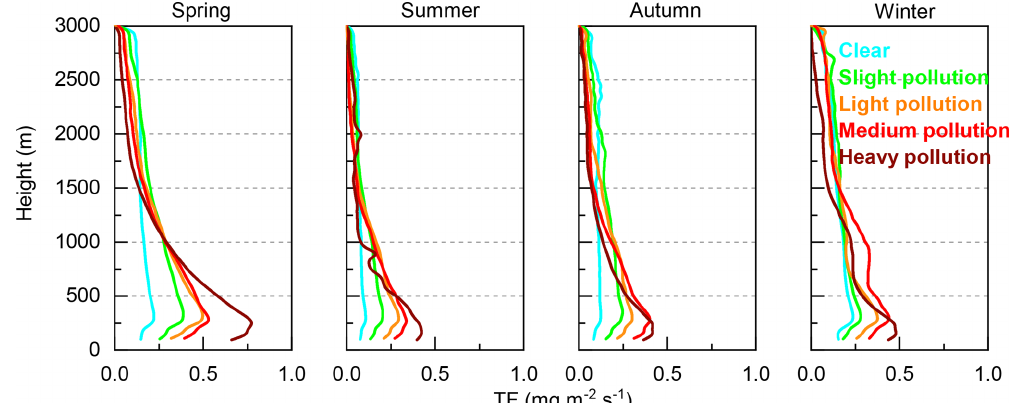
Figure 7. Vertical profiles of TF of PM 2 . 5 under different degrees of pollution in different seasons in Beijing. Clear days: PM 2 . 5 ≤ 35µgm − 3 . Slight pollution: 35 < PM 2 . 5 ≤ 75µgm − 3 . Light pollution: 75 < PM 2 . 5 ≤ 115µgm − 3 . Medium pollution: 115 < PM 2 . 5 ≤ 150µgm − 3 . Heavy pollution: PM 2 . 5 > 150µgm − 3 .